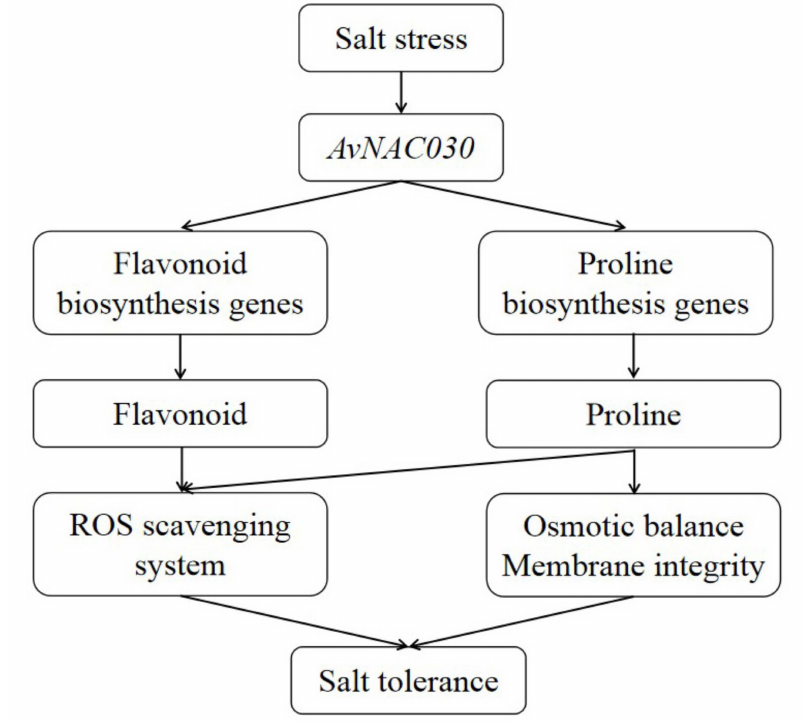
Figure 11. The hypothesis of the regulatory network of the AvNAC030 involved in salt stress